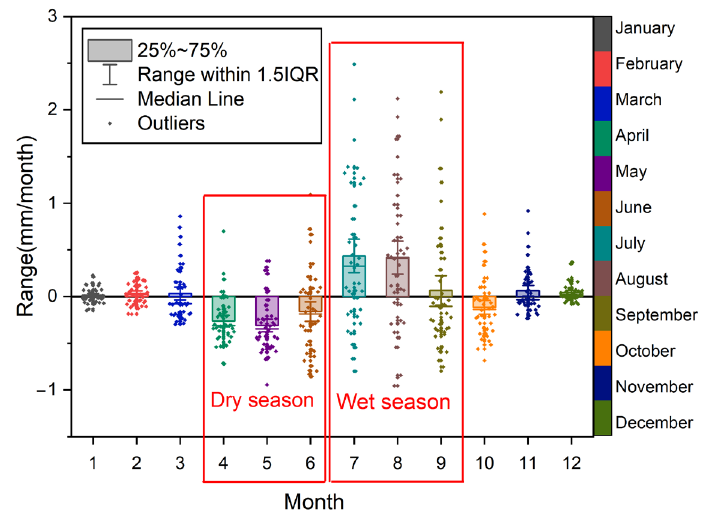
Figure 2. Box chart of the monthly-scale PME (mm/month) in the IMYRB from 1980 to 2021.